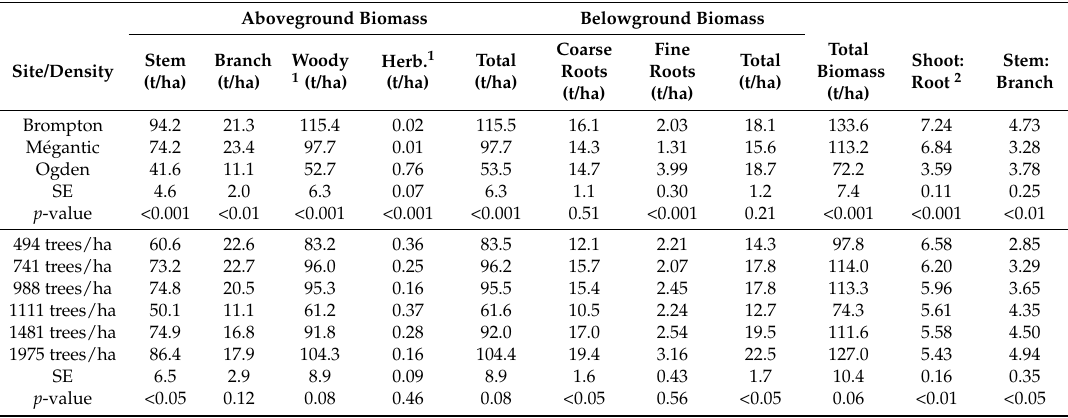
Table 5. Site and Planting density effects on main biomass components at the stand level, on the shoot to root biomass ratio and on the stem to branch biomass ratio in 14 year-old hybrid poplar